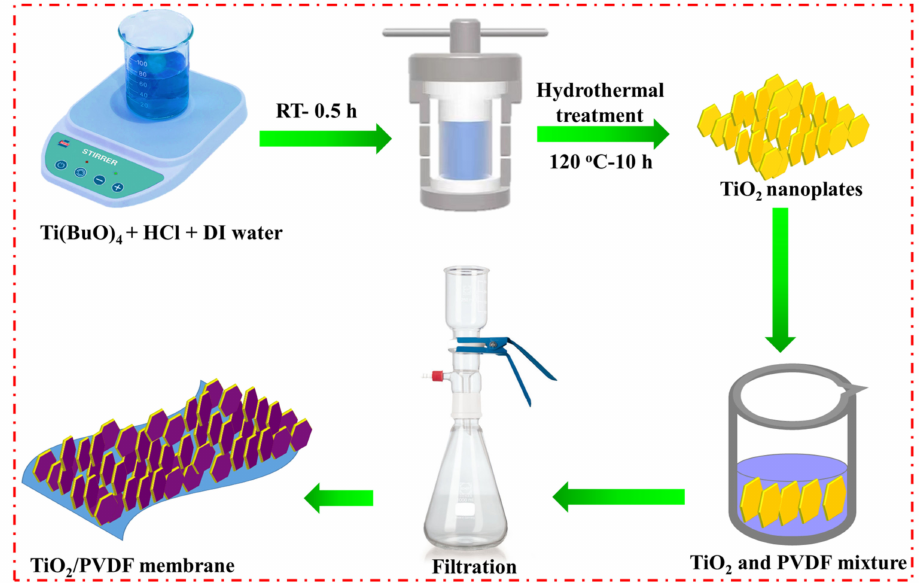
Figure 1. Schematic diagram of the synthesis strategy of TiO 2 /PVDF